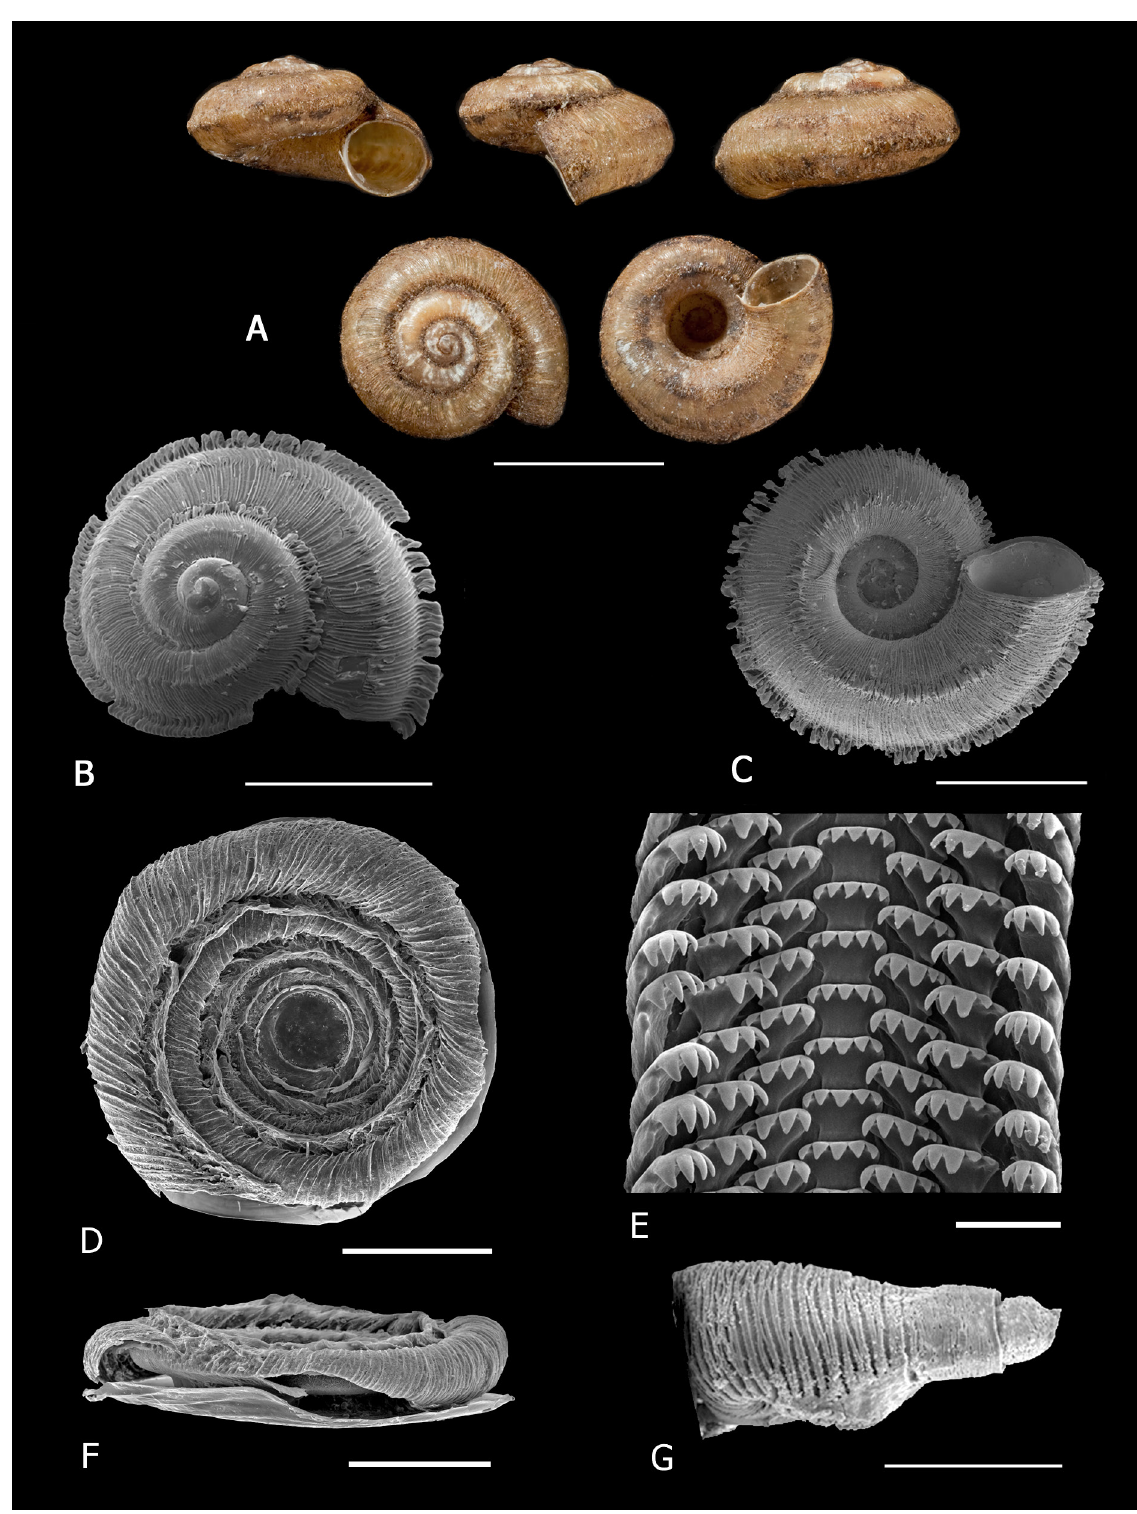
Fig. 15. Chondrocyclus trifimbriatus Connolly, 1929. A . Holotype (NHMUK 1928.3.16.5). B . Dorsal view (ELM W3661). C . Ventral view (ELM W3661). D, F . Operculum (NMSA A8000). E . Portion of radula (ELM W3661). G . Penis, dorsal view (NMSA W1115). Scale bars: A = 3 mm; B–C = 2 mm; D, F–G = 500 µm; E = 20